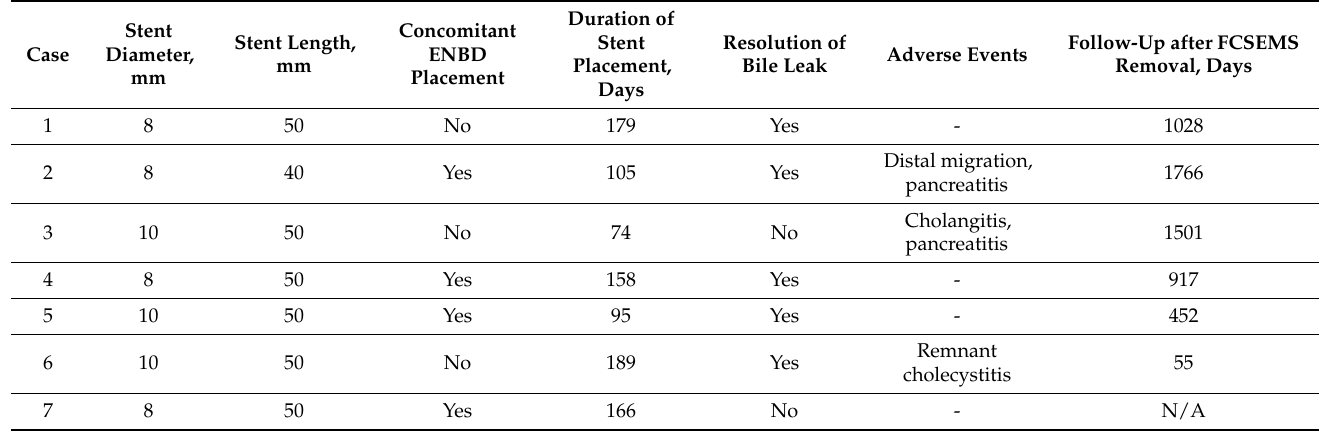
Table 2. Details of the intervention and efficacy of the